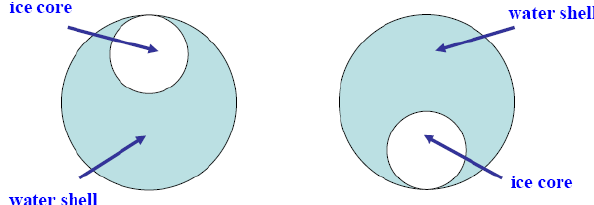
Figure 9: Schematics of off-centre inclusion particles, with the ice core at the top or bottom 813 Fig. 9. Schematics of off-centre inclusion particles, with the ice core of the water shell. 814 at the top or bottom of the water 815